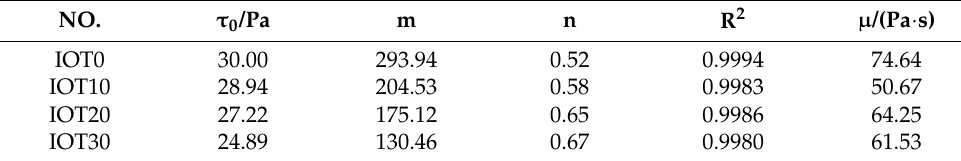
Figure 7. Effect of iron ore tailing on the compressive strength of the designed UHPC. Table 3. Rheological parameters of the designed UHPC mixture with